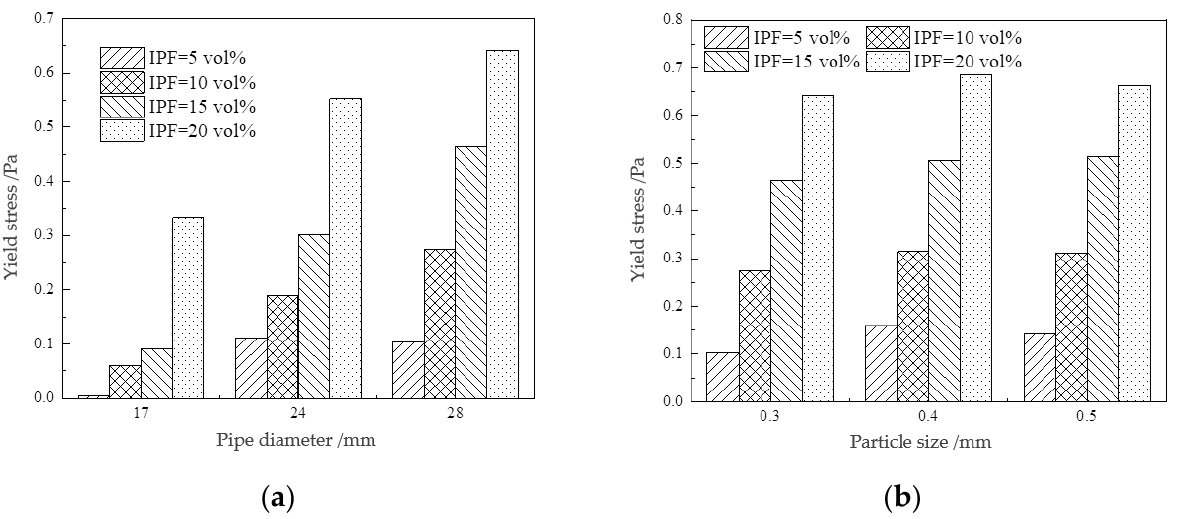
Figure 7. Factors affecting yield stress. ( a ) The relationship between yield stress and pipe diameter;